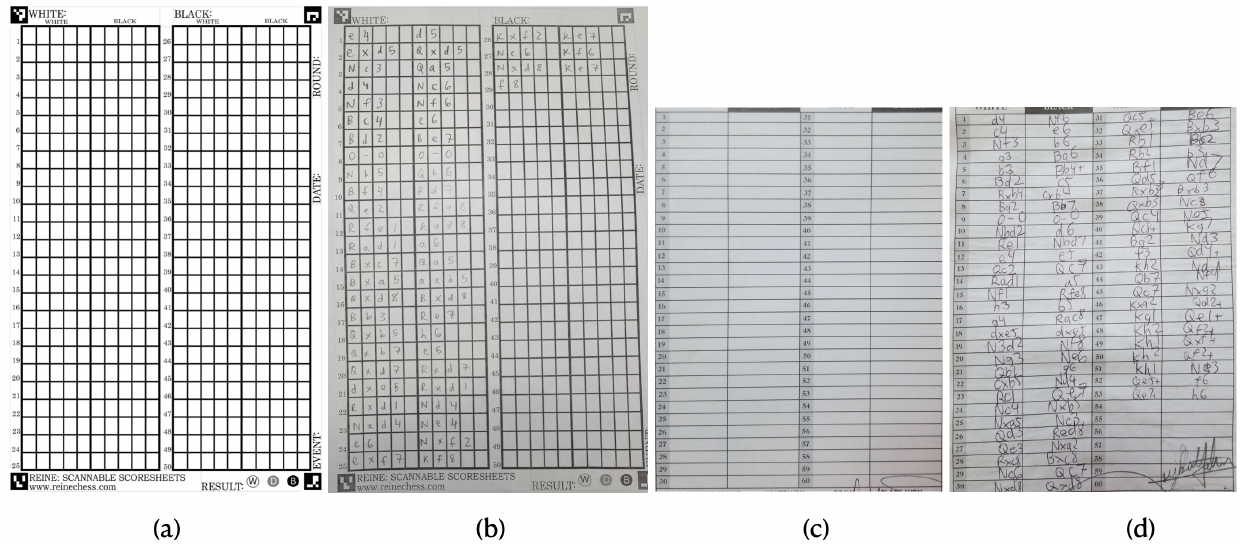
Figure 2. Sample scoresheets from Reine Chess [9] and from an actual chess event: ( a ) Reine blank scoresheet; ( b ) Reine test scoresheet; ( c ) sample standard blank chess scoresheet; and ( d ) sample filled chess